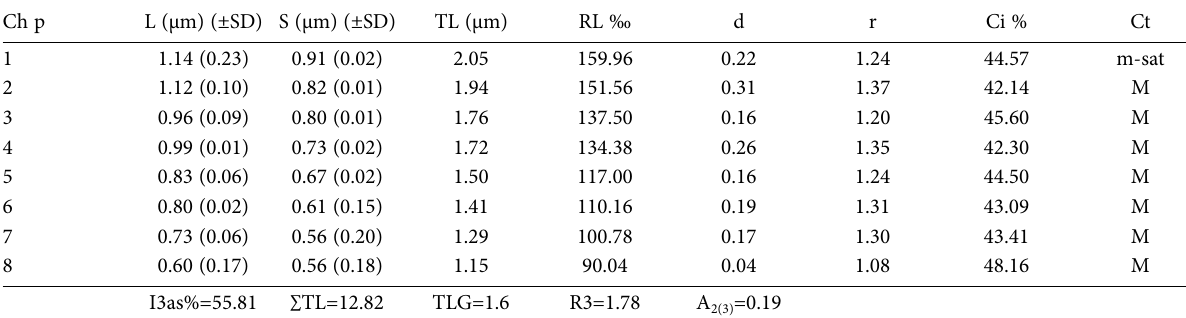
Table 4. Morphometric data within the population 25/10 (2n=16) of Trifolium subterraneum L. in Algeria. Ch